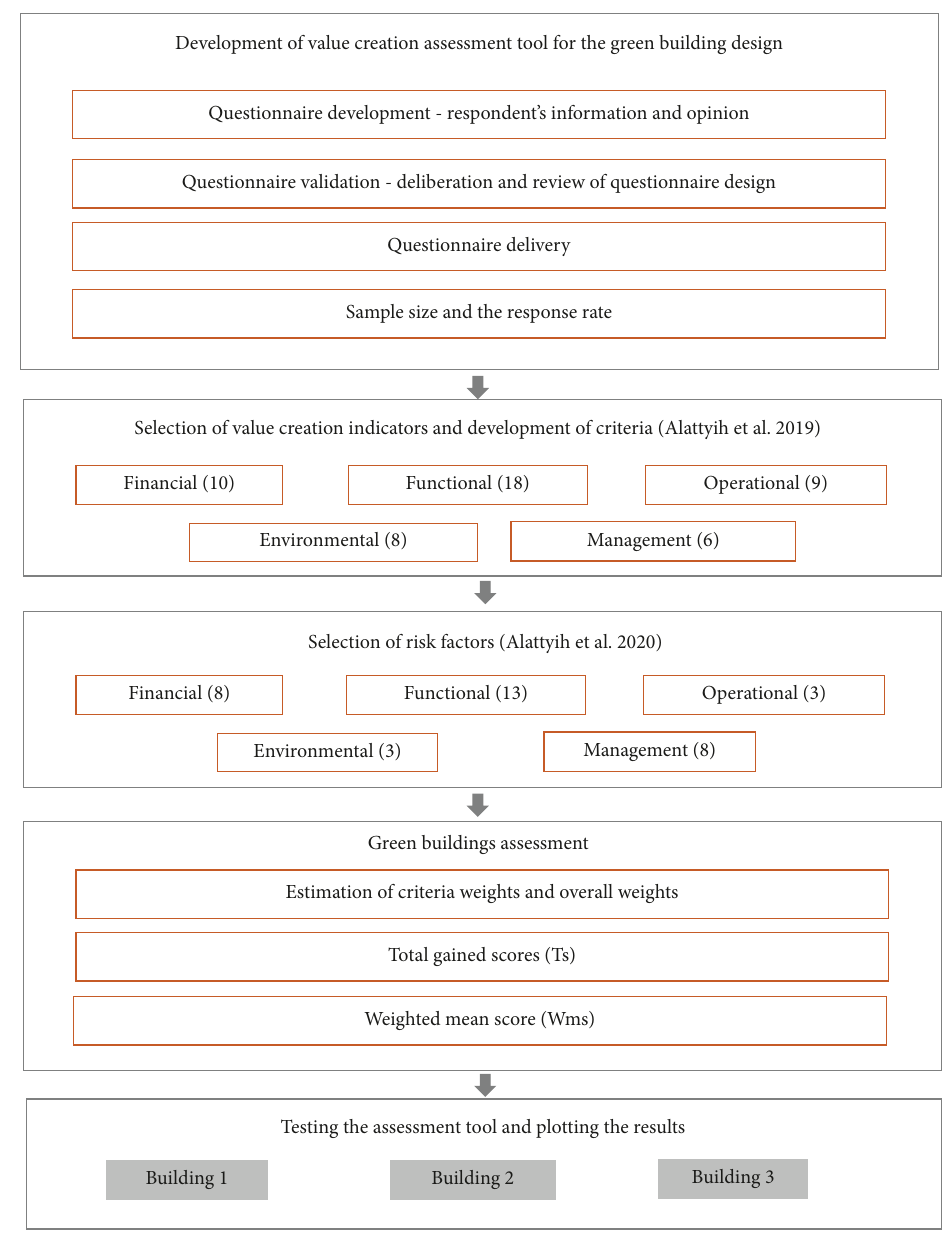
Figure 1: Methodological framework for value creation assessment